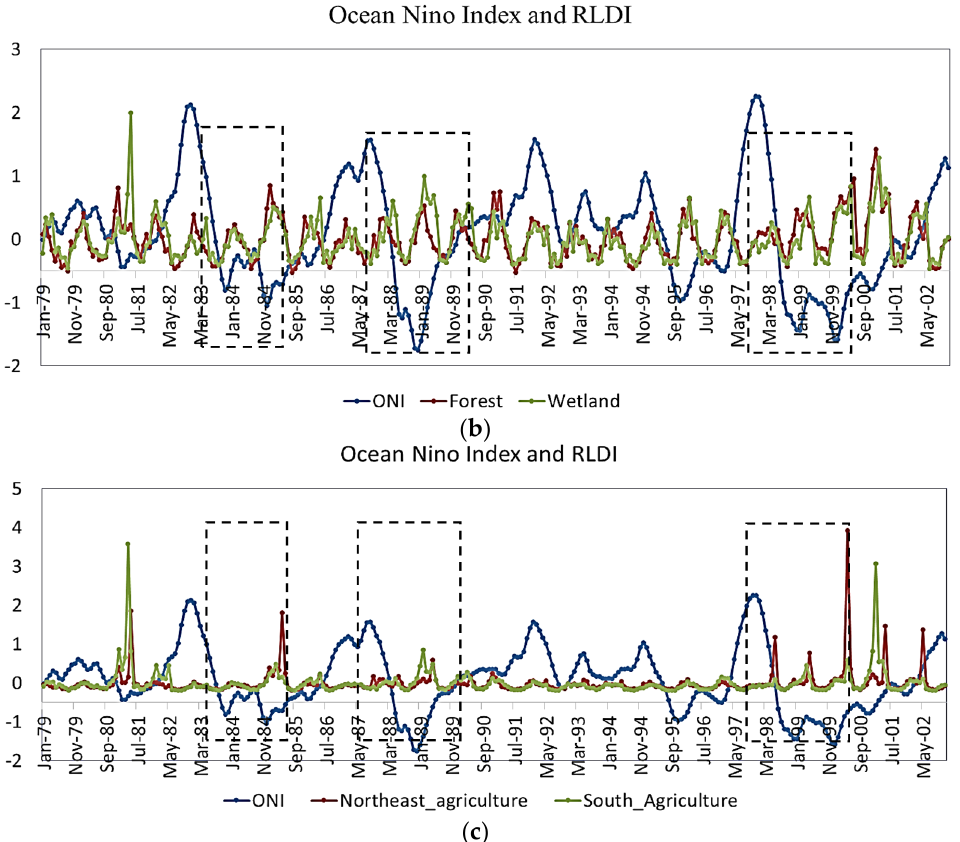
Figure 14. ( a – c ) Time Series Plots of ONI and RLDI; block boxes represent La Nina episodes.